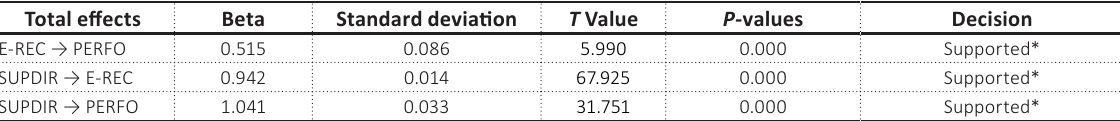
Table B4. Total effects